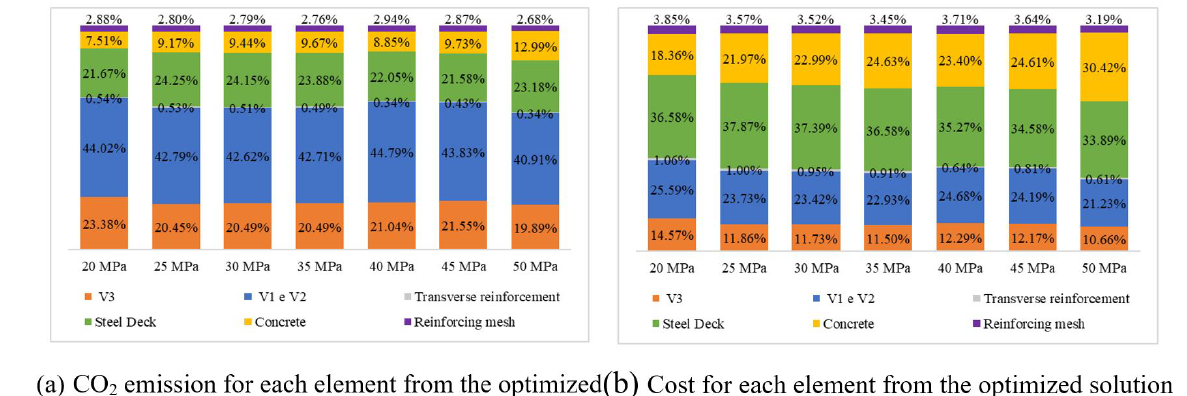
Figure 5. Optimized solution for example